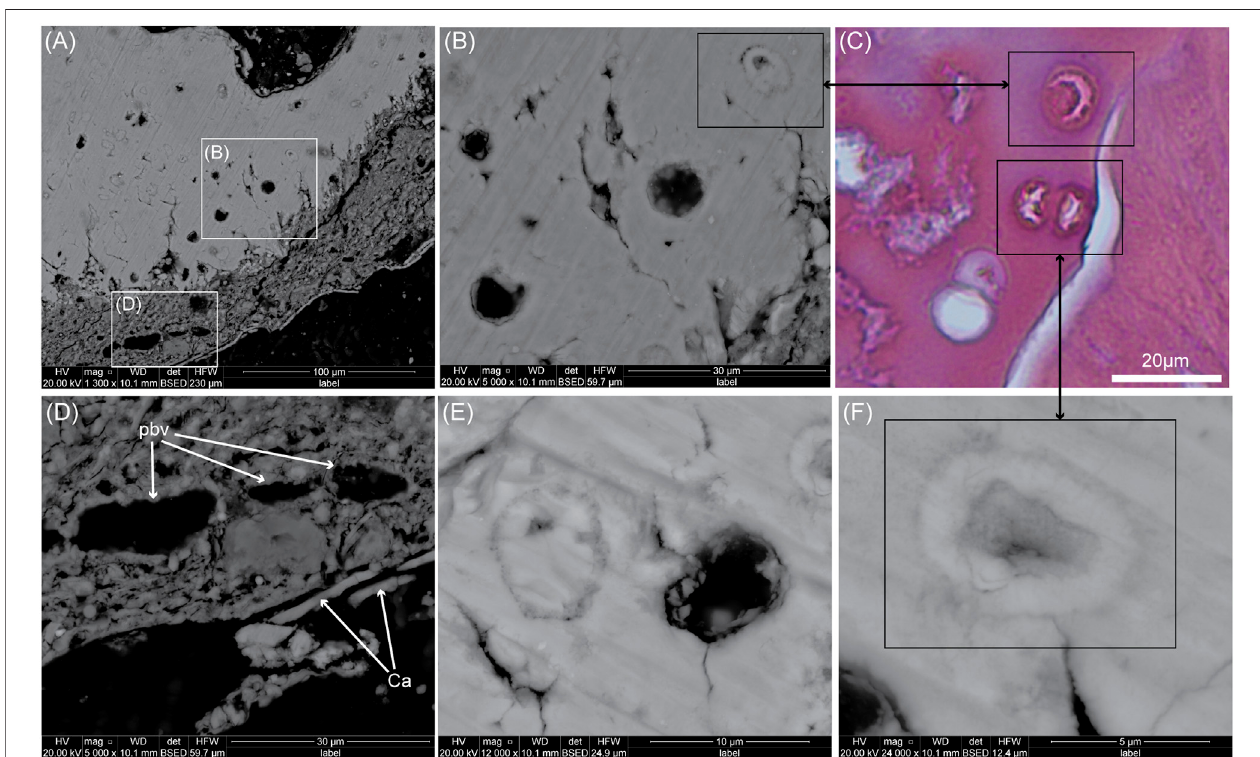
FIGURE 2 | SEM images of another ground-section of Yanornis (IVPP V13358). (A) SEM image on the calci fi ed cartilage (upper part) and originally unmineralized cartilage (ouc, lower part). (B) Close-up on some chondrocyte lacunae. (C) Comparison with a paraf fi n section of extant galliform calci fi ed cartilage stained with H&E. Somelacunaearebeing fi lledinwithmineralizedmaterial(potentiallysimilartomicropetroticlacunaeseeninmammalbone).Theyshowsimilarmorphologiesasthoseof Yanornis (i.e., with a moon-shaped center, or polygonal center). (D) Close-up SEM image on the ouc. These tubular structures are potential blood vessels (pbv), meaning the soft tissues originally identi fi ed as ouc most likely also contains vascularized collagenous tissues. It is covered by a thin layer of calcium (Ca). (E) High- magni fi cation SEM image on two types of chondrocyte lacunae in Yanornis . (F) High magni fi cation on a micropetrotic chondrocyte lacuna apparently being fi lled in by calci fi ed matrix perhaps triggered by chondrocyte death and the loss of mineralization inhibitors.